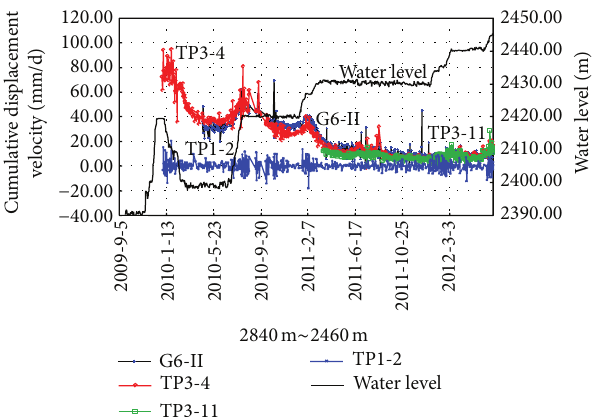
Figure 4: The displacement rule for different points of different elevations.